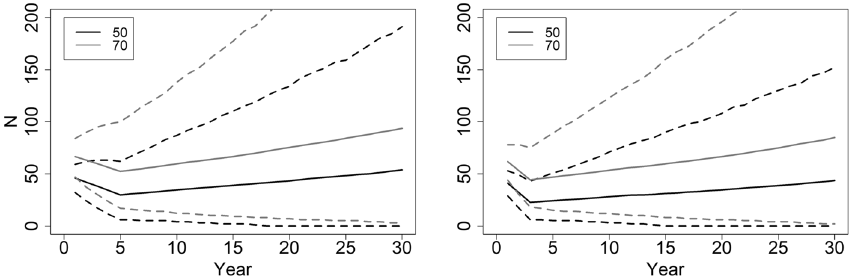
Figure 4. Abundance trajectories of adult females, with removals of 5 adult females during each of the first 5 consecutive years (left), and the removal of 10 adult females during each of the first 3 consecutive years (right). Mean abundances are solid lines with dashed lines representing 90% confidence intervals. Given these 5 or 10 removals, starting abundance must be ≥ 70 adult females for the population to return to a mean of 70 within 30 years without the lower confidence interval reaching 0. Inset values indicate the starting abundances of adult